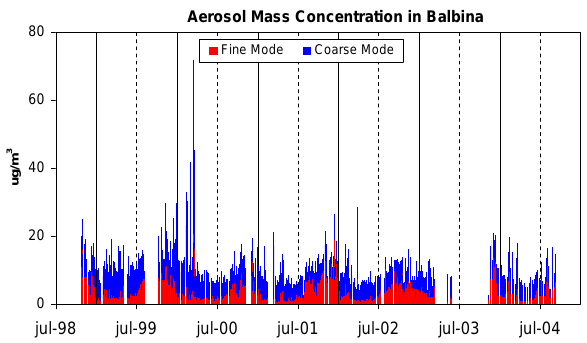
Fig. 3. The aerosol mass concentration time series at Balbina from October 1998 to September 2004. Concentrations are shown sep- arately for Fine Particulate Mass (FPM, d p < 2 . 5µm) and Coarse Particulate Mass (CPM, 2.5µm < d p <